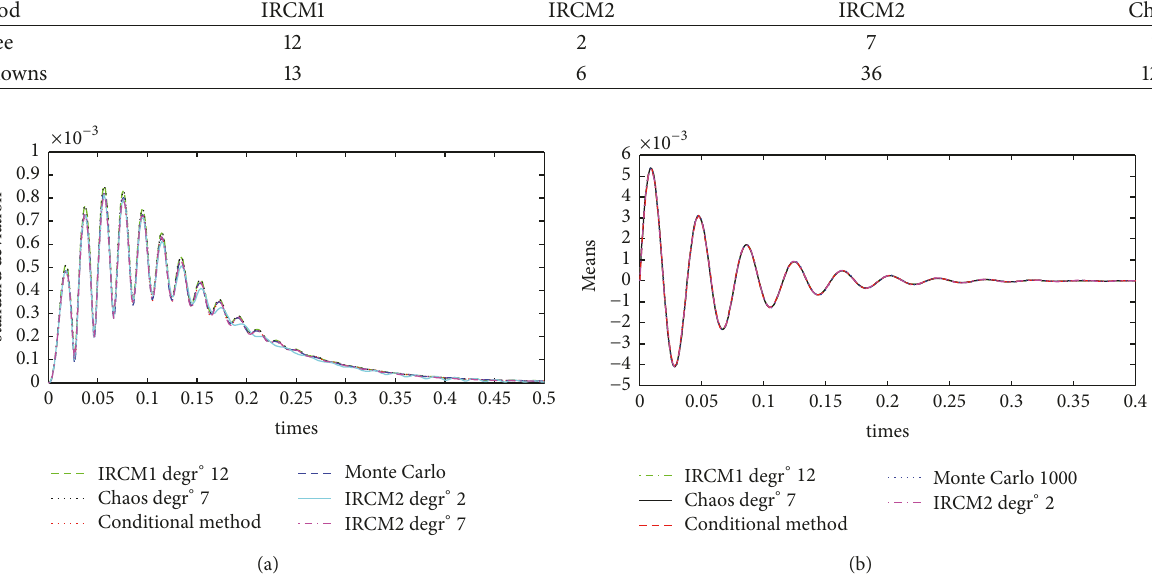
Figure 1: (a) Standard deviation of 𝑈 when 𝜉 𝑖 follow the truncated exponential law in [0, 10] and 𝜎 𝑖 = 5%. (b) Means of 𝑈 when 𝜉 𝑖 follow the truncated exponential law in [0, 10] and 𝜎 𝑖 = 5%.